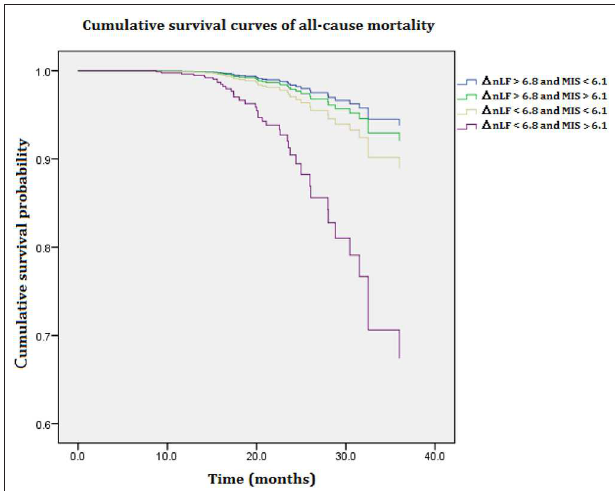
( P = 0.062 and 0.182 for the interaction term,